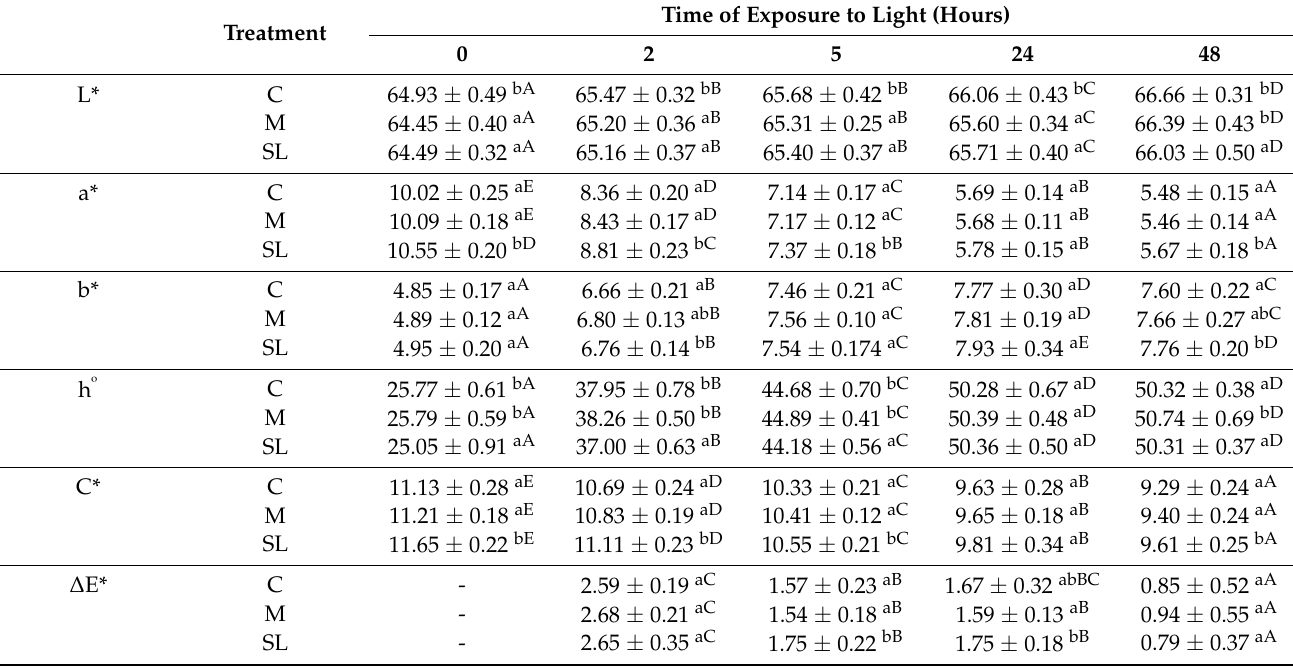
Table 2. The colour parameters (L*, a*, b*, hº, C*, ∆ E*) of the model meat products tested after exposure to light after production (means ± standard